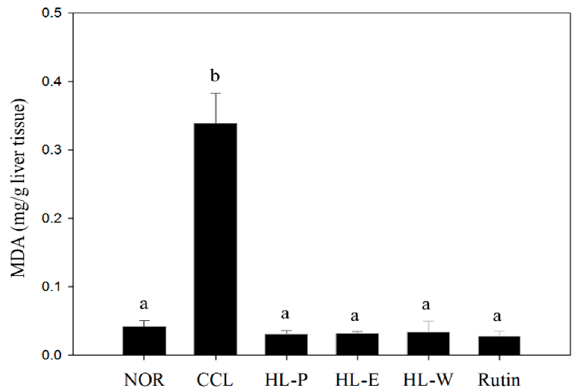
Figure 1. The effects of red quinoa and its extracts on the liver TBARS assay of CCl 4 -induced liver injury mice. NOR: normal group, CCL: CCl 4 -induced liver injury mice, HL-P: CCl 4 -induced liver injury mice fed 5.13 g/kg (rutin 8.46 mg/kg) of red quinoa-powder, HL-E: CCl 4 -induced liver injury mice fed 1.54 g/kg (rutin 16.4 mg/kg) of red quinoa-ethanol extracts, HL-W: CCl 4 -induced liver injury mice fed 1.54 g/kg (rutin 3.92 mg/kg) of red quinoa-water extracts, Rutin: CCl 4 -induced liver injury mice fed 16.4 mg/kg of rutin. Data are presented as mean ± SD ( n = 8). a,b Different letters indicate significantly different values according to a one-way ANOVA using Duncan’s multiple test ( p <